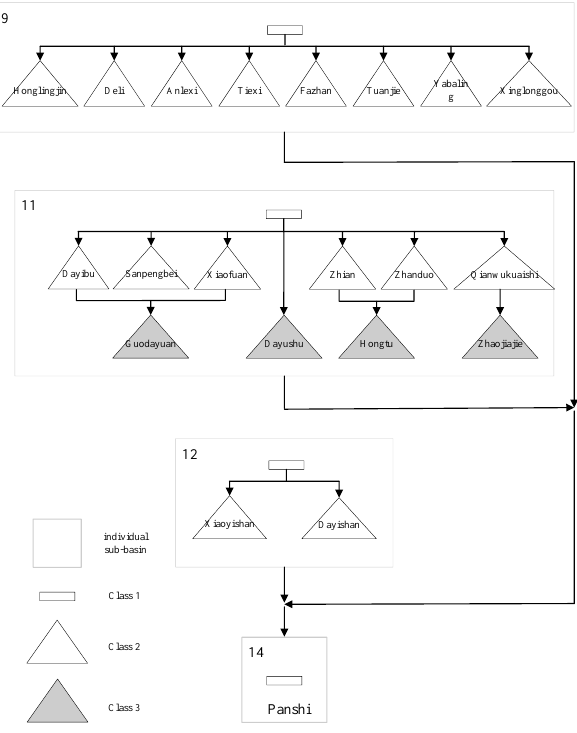
Fig. 4 Spatial topology of the water storages in the Panshi sub-basin Fig. 4. Spatial topology of the water storages in the Panshi sub-basin Additionally, “9”, “11”, “12” and “14” in rectangles (individual sub- Additionally, “9”, “11”, “12” and “14” in rectangles (individual sub-basins) mean the basins) mean the numbers of individual numbers of individual sub-basins.